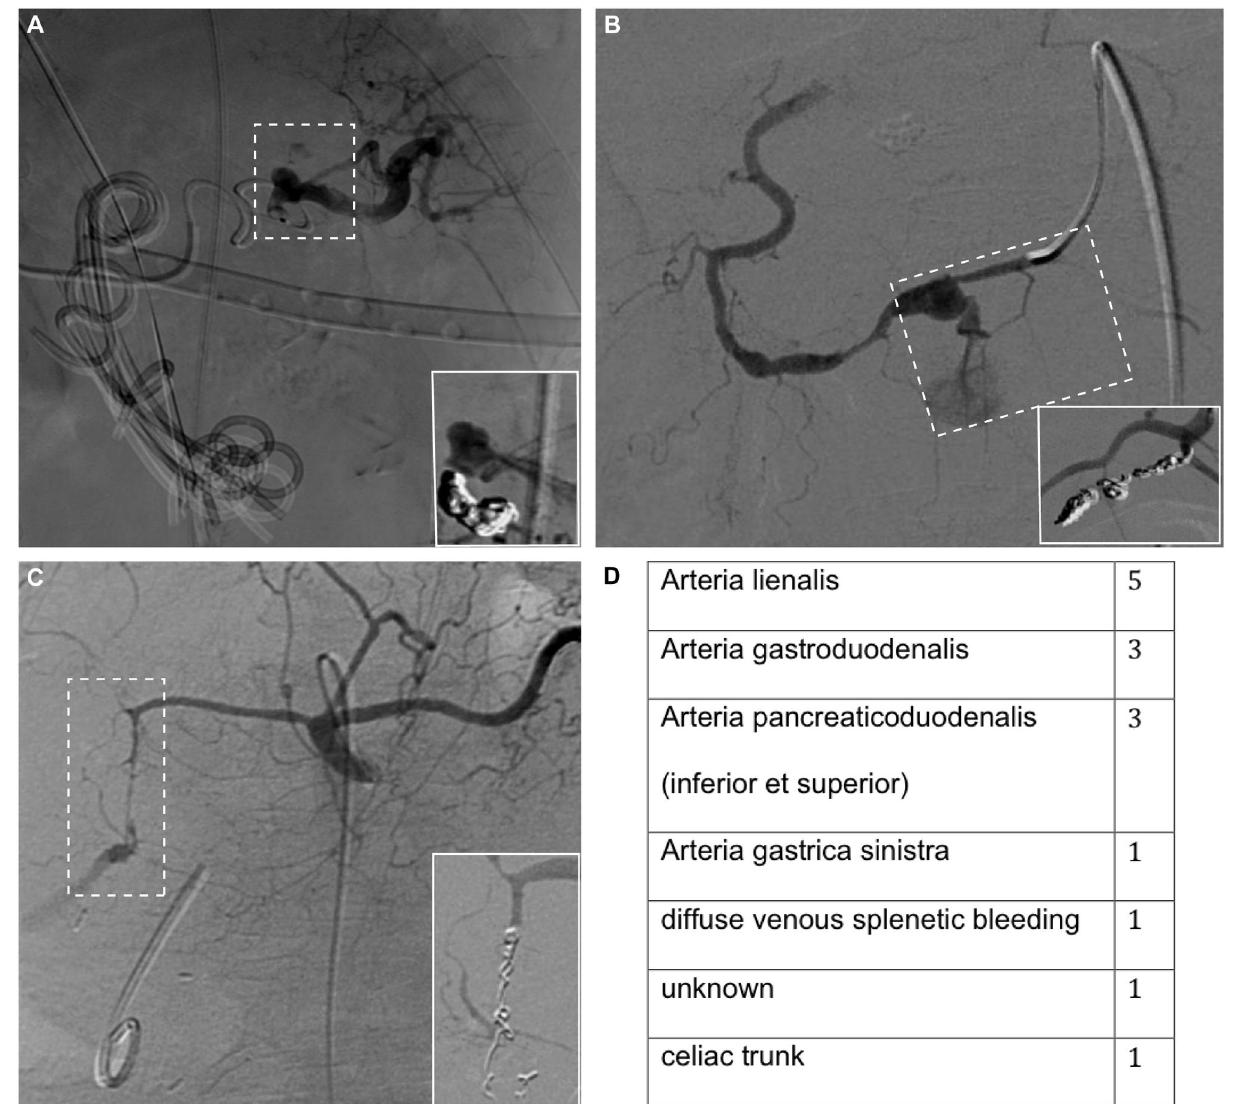
Figure 1. Illustration of bleeding vessels before and after transcatheter arterial coil embolization. Digital subtraction angiography showing bleeding of arteria lienalis (A), arteria pancreaticoduodenalis inferior (B), and arteria gastroduodenalis. Inlets demonstrate transarterial coil embolization. The localizations of intraabdominal bleedings are shown in the table (D).